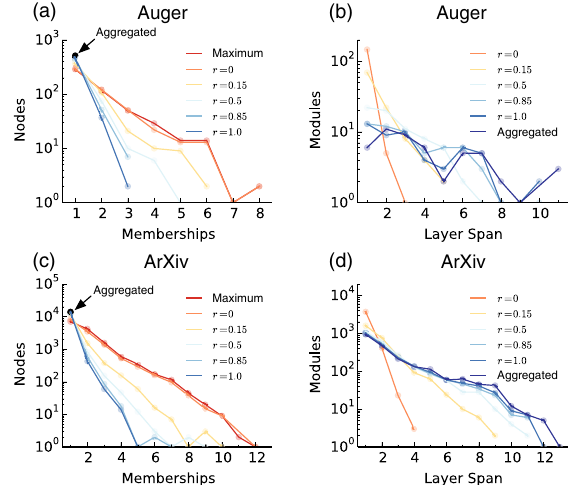
FIG. 6. Aggregation is responsible for significant changes in the community structure. The panels show module sizes, number of assignments per node (overlap), and NMI for communities revealed from the multilayer and the aggregated networks in the Pierre Auger Collaboration (top panels) and the arXiv (bottom panels) networks. For a given relax rate, the NMI measures the similarity between the obtained partition and the partitions ob- tained from the aggregated topology (blue curve) and the aggre- gated dynamics at relax rate r ¼ 1 . 0 (red curve), respectively.